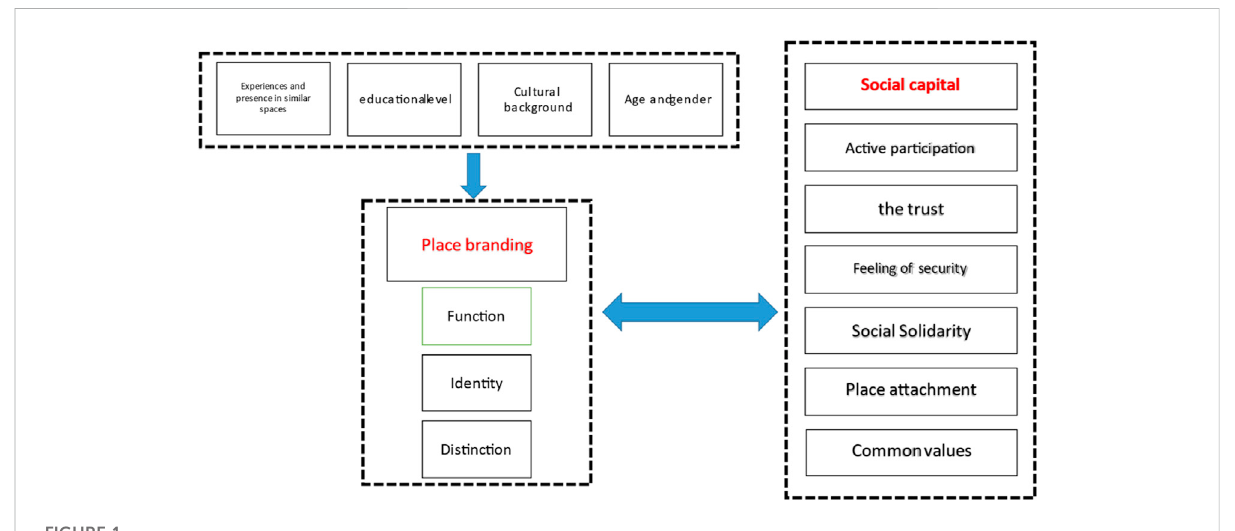
FIGURE 1 Conceptual model of the